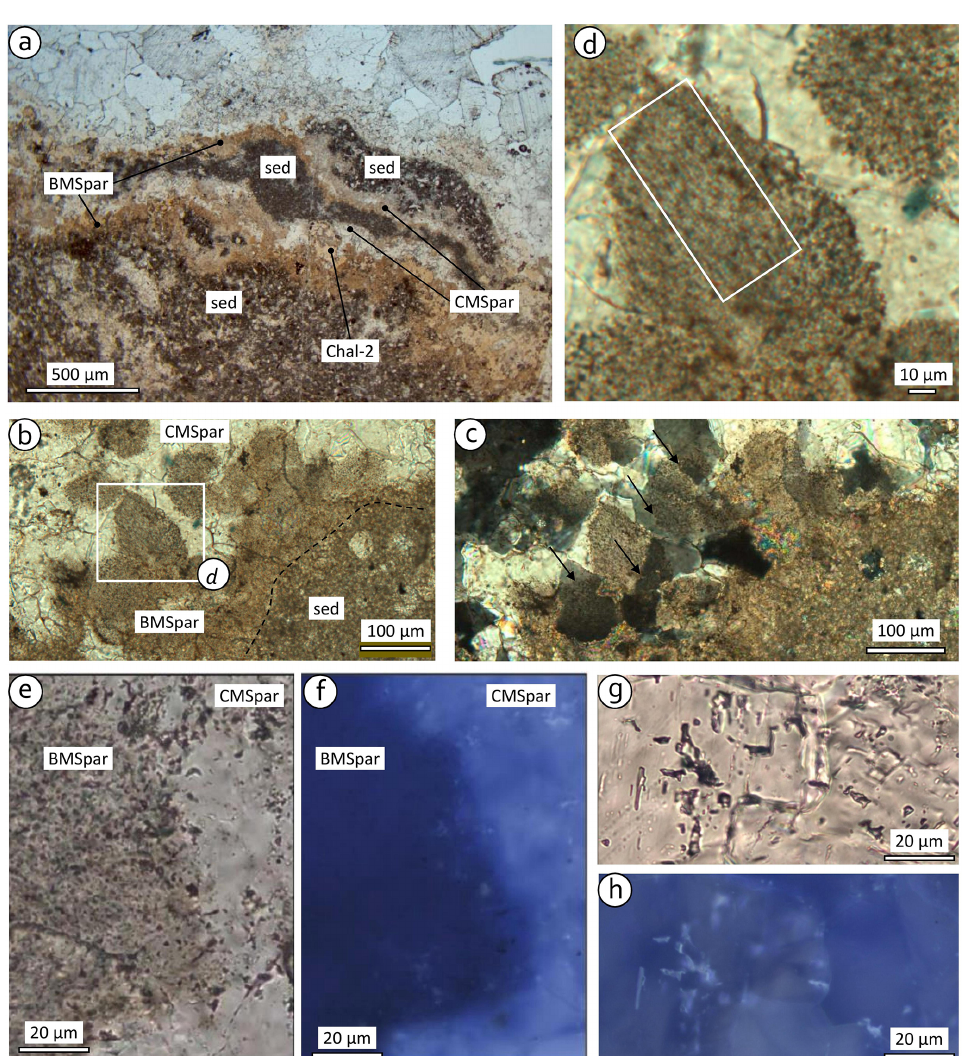
Figure 12. Microphotographs showing details of sediment–cement sequences. (a) Repeated sequence of sediment (sed), brown microsparite (BMSpar), and clear microsparite (CMSpar), locally overprinted by chalcedony (Chal-2). (b) Detail of BMSpar–CMSpar contact (black dashed line follows the underlying BMSpar–sediment contact); BMSpar appears as a set of filamentous “bushes”; the white rectangle marks the area shown in detail in (d) . (c) As (b) in cross-polarized light, showing individual microspar crystals straddling across BMSpar–CMSpar boundaries (marked by black arrows). (d) Close-up of filamentous bush; note the elongate brown inclusions within clear crystal, particularly in white rectangle. (e, f) BMSpar–CMSpar contact in plane light (e) and UV epifluorescent light (f) ; fluorescent inclusions near the margin of BMSpar following oblique contact between BMSpar and CMSpar into the thin section. (g, h) Typical CMSpar in plane light (g) and UV epifluorescent light (h) , fluorescence originating from both fluid inclusions (bright white) and microspar (dull